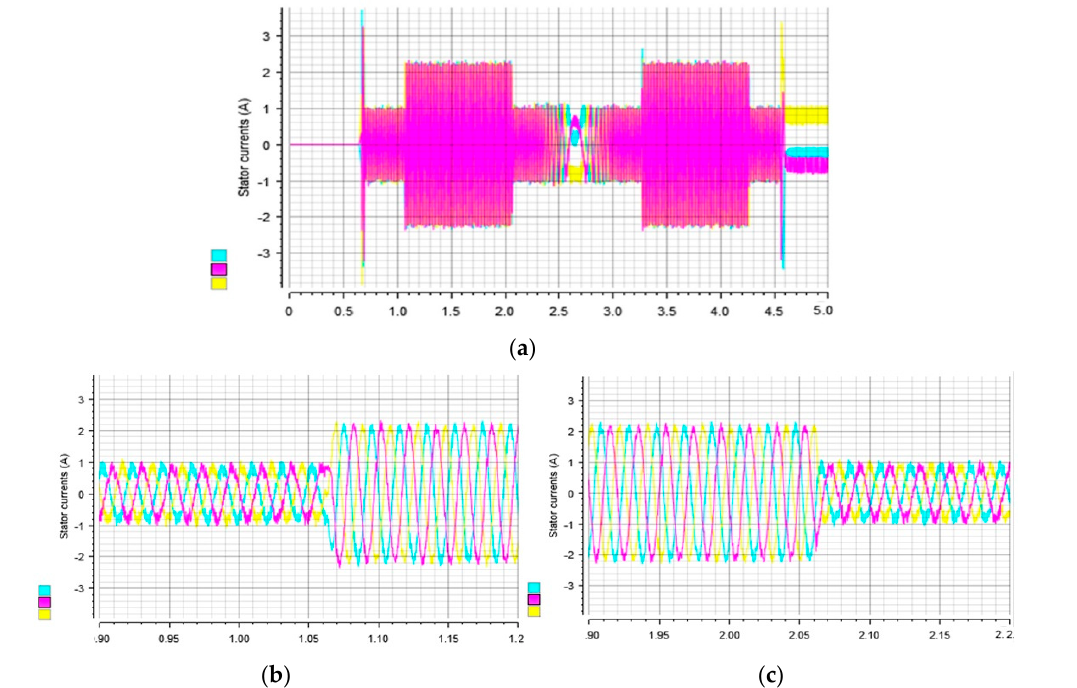
Figure 21. Speed ( a ) and torque ( b ) of the GA–DTC.